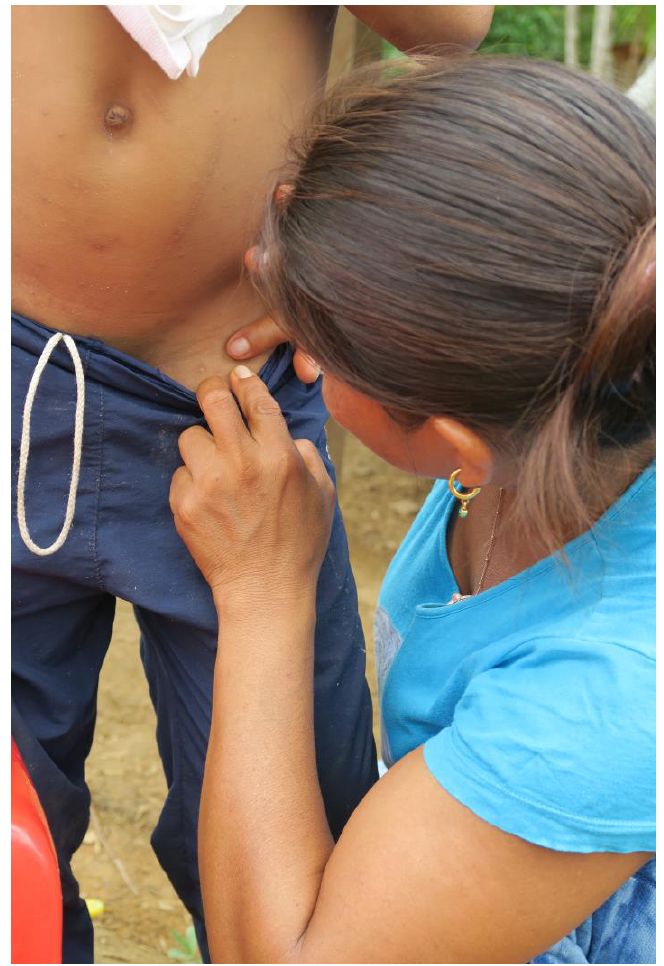
Figure 1. Experienced mother examining the skin of a child for the presence of a pearly vesicle.